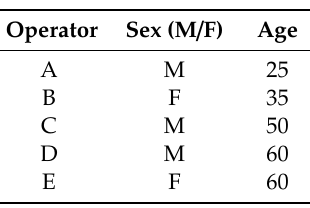
Table 6. Operator’s characteristics.